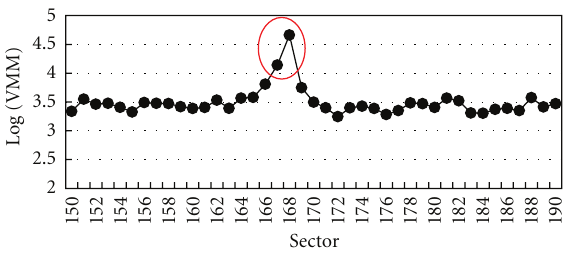
Figure 2: VMM changes near the error position.